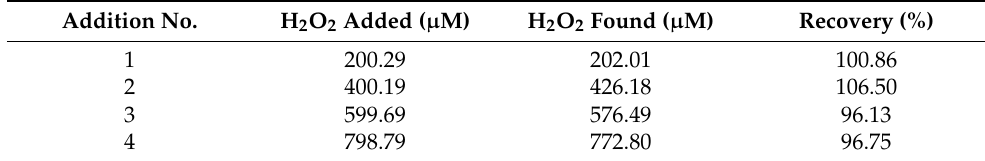
Table 4. Determination of H 2 O 2 in L. plantarum from Brown Rice.